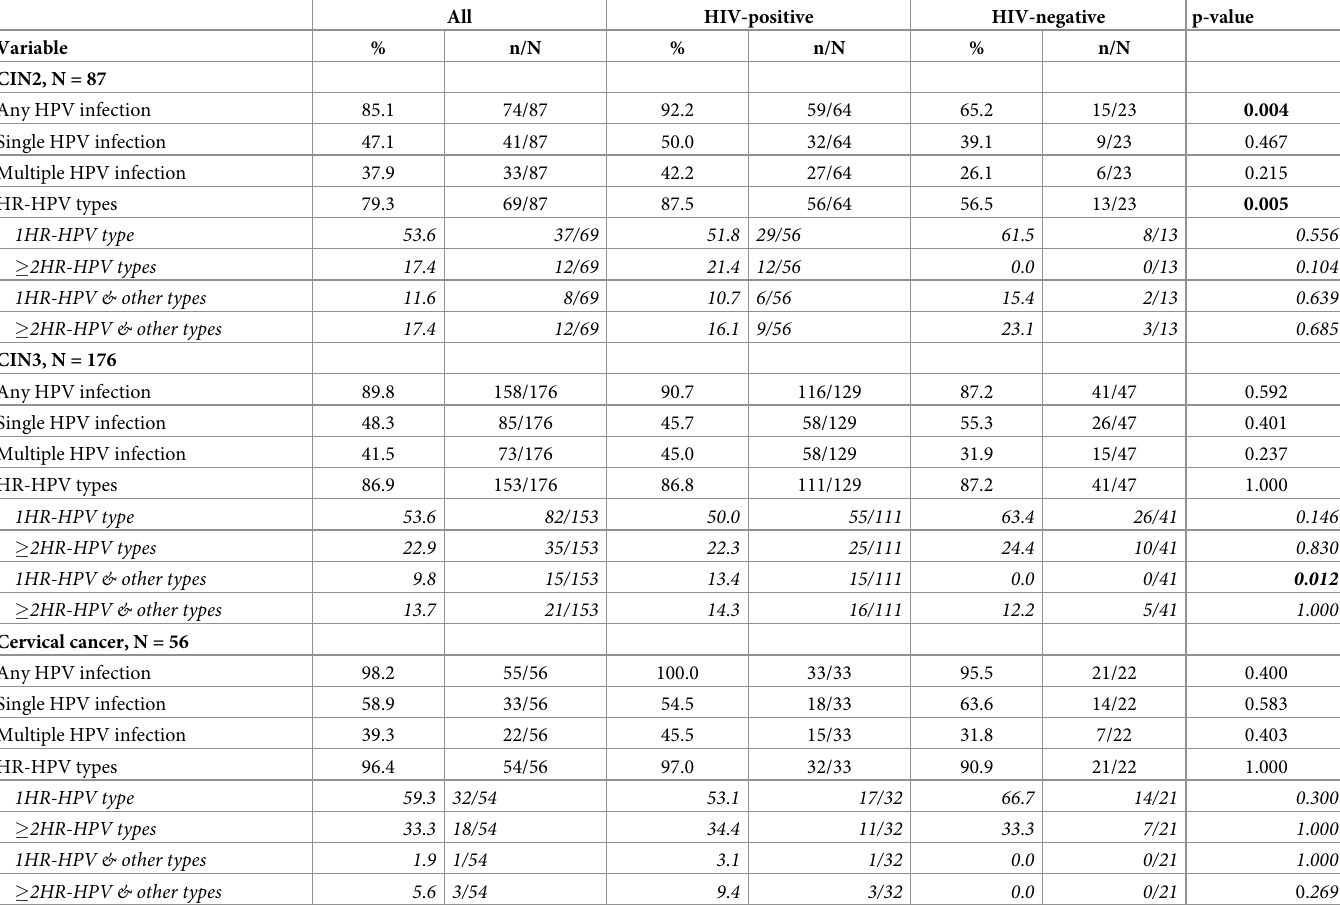
Table 3. Human papillomavirus prevalence according to cervical histology data among women referred to Nelson Mandela Academic Hospital Gynaecology depart- ment, Eastern Cape Province.